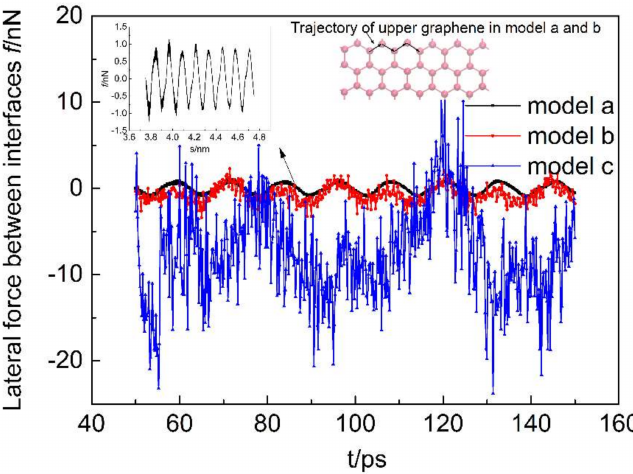
Figure 2. The lateral force between interfaces in models a, b and c. In model b and c, the hydrogen groups ratio on the upper and lower graphene layers is 0%/5% and 5%/5%, respectively. The inset curve shows the lateral force with move distance in x direction in model a. The trajectories of the upper graphene layer in model a and b are similar, which is illustrated in the upper right